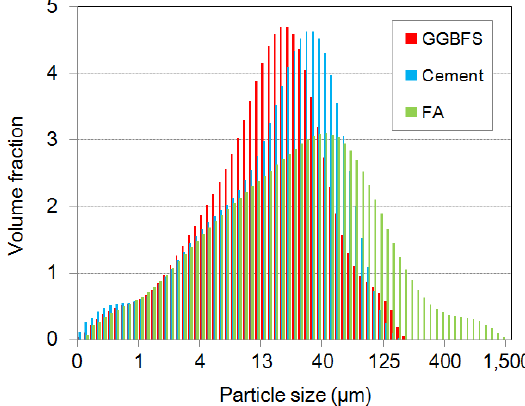
Figure 1. Measured particle size distribution of cement, ground granulated blast-furnace slag (GGBFS), and fly ash (FA).